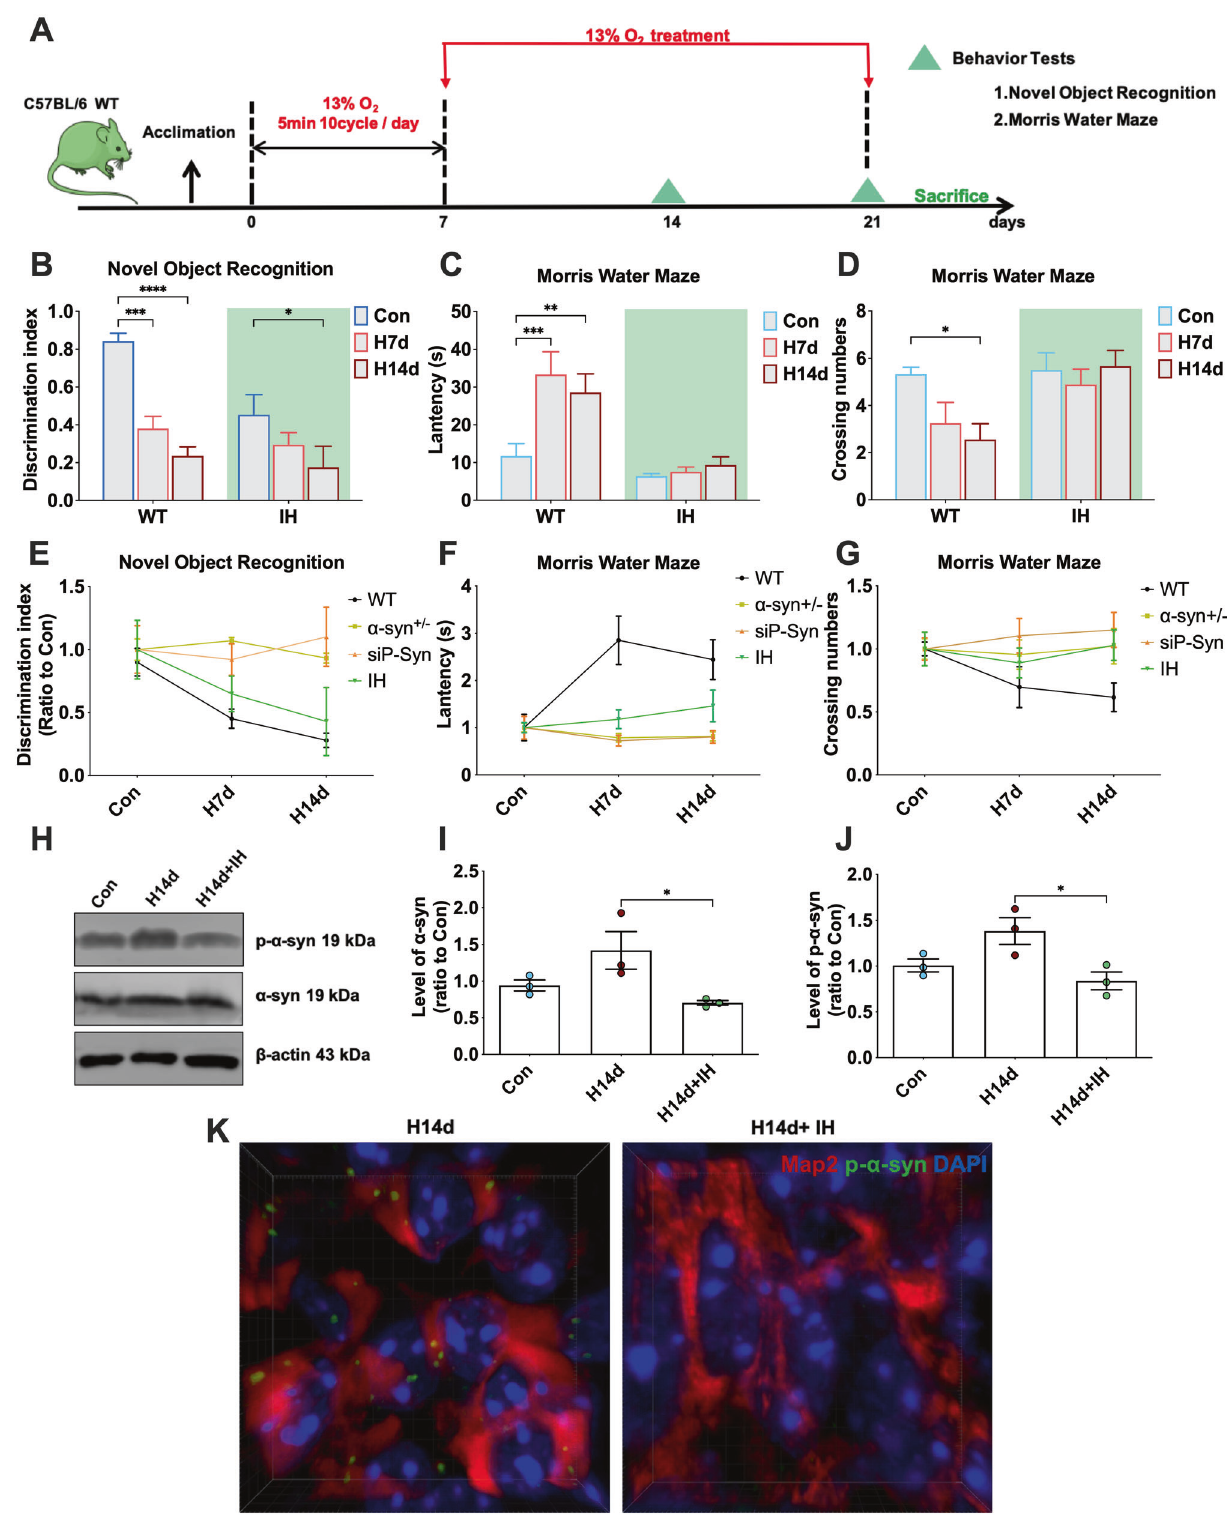
mechanisms, and provided a reliable molecular target for subsequent research. Meanwhile, we also revealed the role of IHPC in resistance to chronic hypoxic injury, which provided a new perspective for the intervention of many hypoxia-related